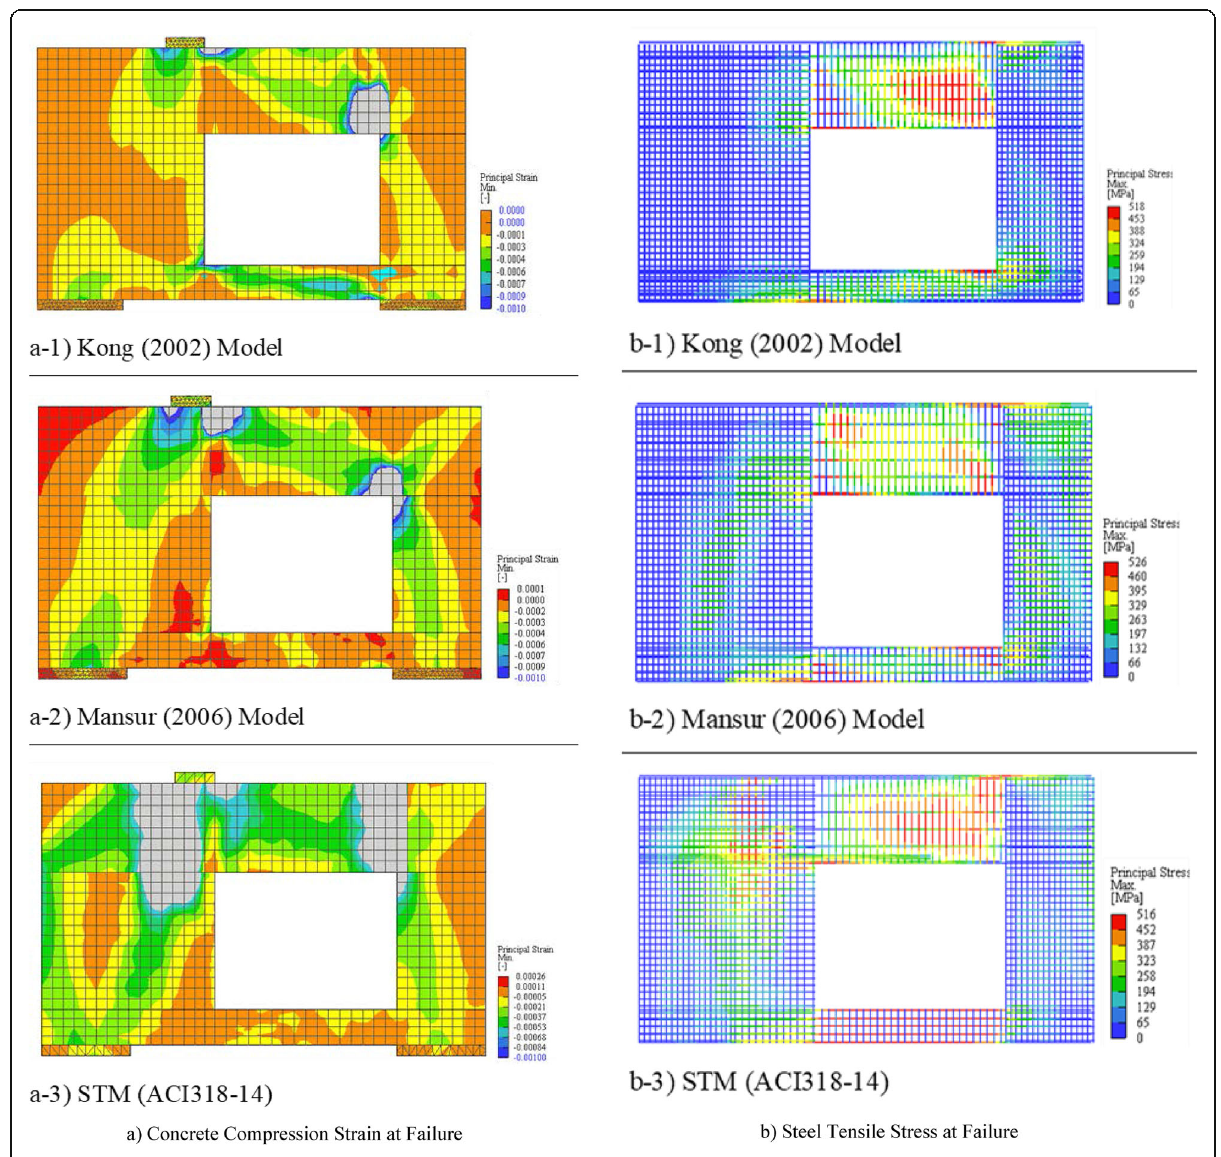
Fig. 9 a Concrete compression strain at failure. b Steel tensile stress at failure